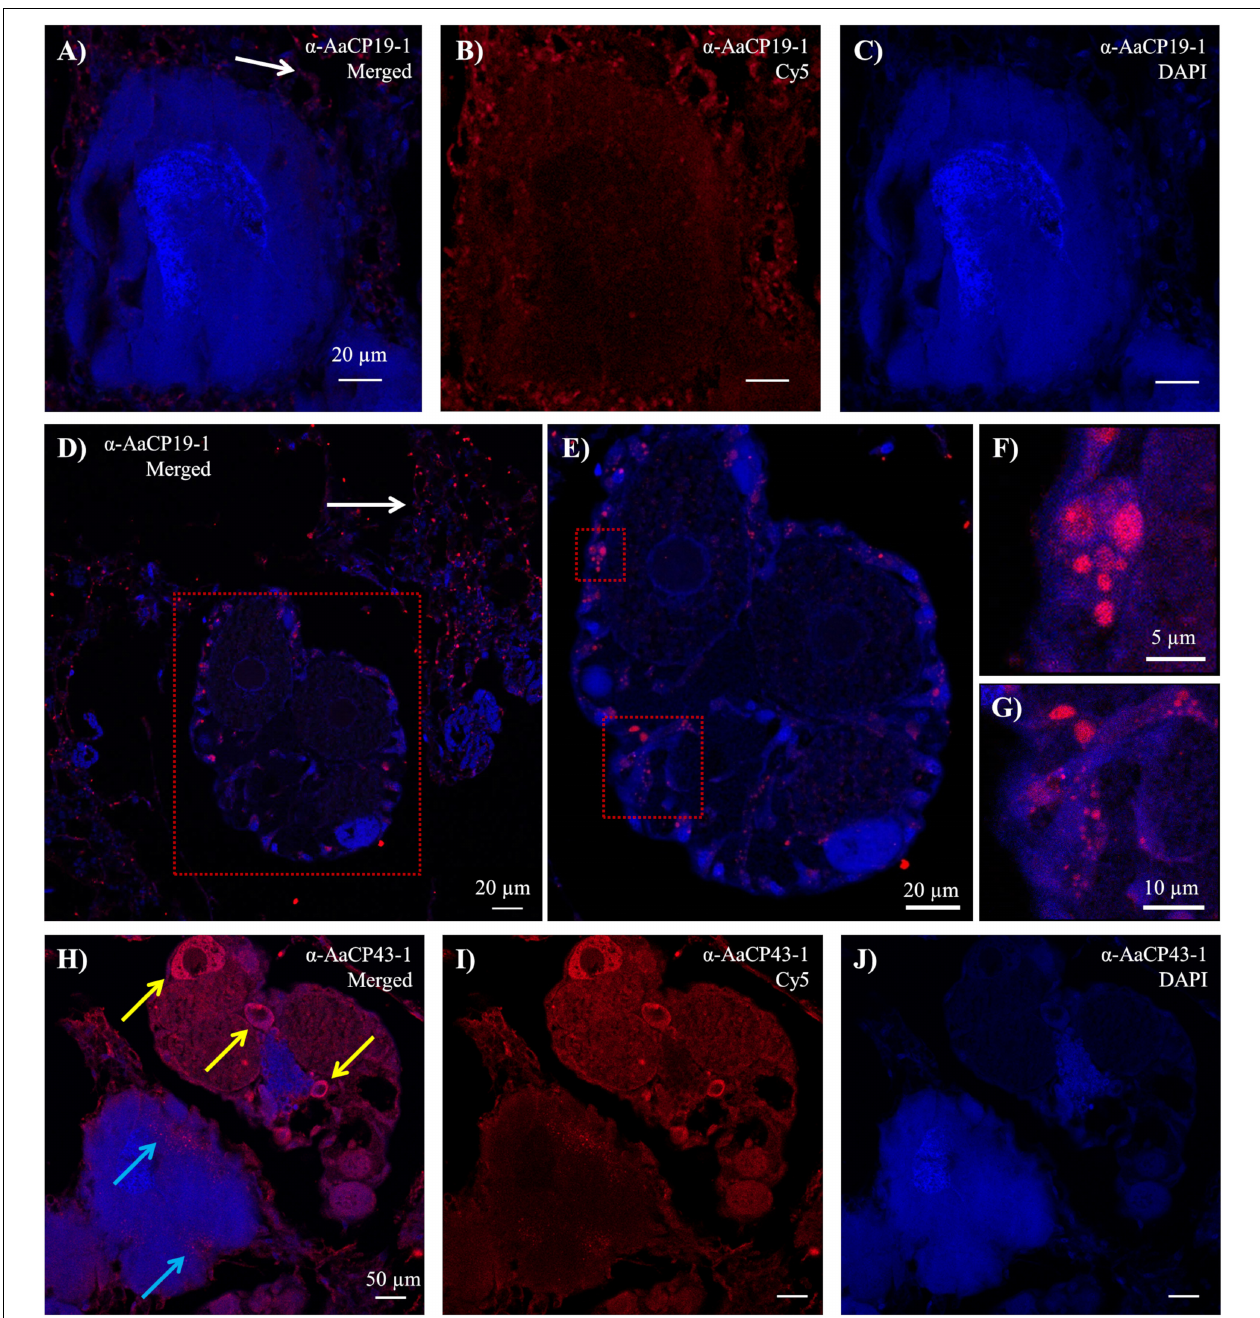
FIGURE 3 | Immunohistochemistry results from transverse sectioned sub-mantle tissue. (A–G) Confocal images with Cy5-labeled α -AaCP19-1. (A) Merged image of the (B) Cy5 channel showing secondary signal and the (C) DAPI channel of sections incubated with α -AaCP19-1. (D–G) Ovariole at varying magnifications showing distinct Cy5-labeled features mainly in small cells at the periphery of the ovariole. Red box in panel (D) is the field of view in panel (E) . Red boxes in panel (E) are the fields of view shown in panels (F,G) . Punctate positive staining in connective tissue is indicated in panels (A,D) with white arrows. (H–J) Confocal images with Cy5-labeled α -AaCP43-1 showing signal in both ovarioles and cement glands. (H) Merged image of (I) Cy5 channel and (J) DAPI channel. Punctate signal can be seen in the cement glands (blue arrows) and in the cytoplasm of large cells within ovarioles (yellow